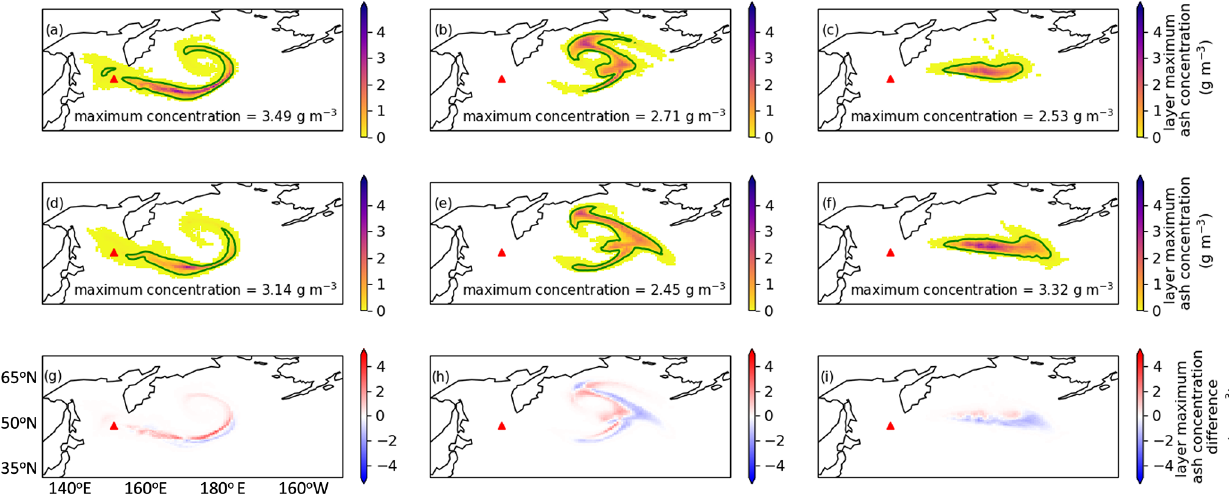
Figure 8. Maximum layer ash concentration (gm − 3 ) for (a, d) near surface (0–4km), (b, e) troposphere (4–12km) and ( c, f) stratosphere (above 12km), for ensemble member 5 (a–c) and member 9 (d–f) at 12:00UTC on 23 June 2019. The green contour denotes the 200µgm − 3 concentration level. The lowest ash concentration shown in (a–f) is 100µgm − 3 . Panels (g–i) show the difference between maximum layer concentrations for member 5 and member 9, also at 12:00UTC on 23 June